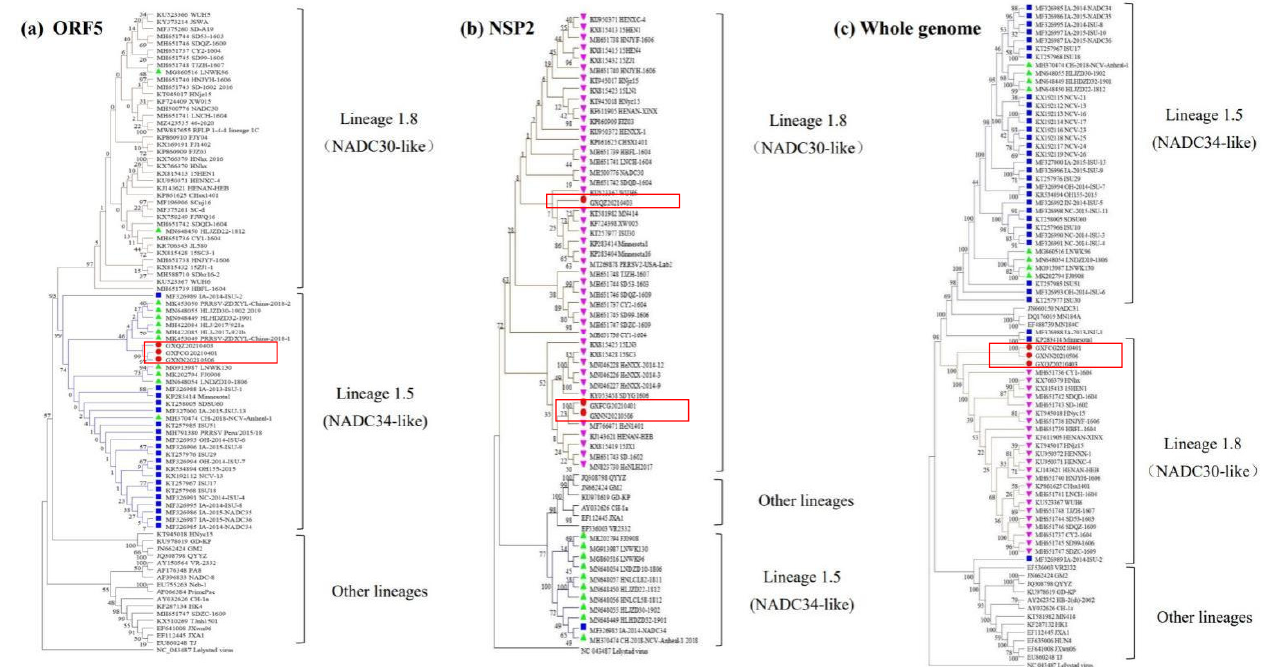
Figure 2. ( a ) Genetic evolutionary tree of the ORF5 gene. ( b ) Genetic evolutionary tree of the nsp2 gene. ( c ) Genetic evolutionary tree of the full-length genome. The categorization of the sub-lineage was based on the description by Shi et al. [10]. The phylogenetic tree was constructed using the Mega 6.0 distance-based neighbor joining method, with a total of 1000 replicates. The virus strains obtained in this study are marked with red circles and red boxes. The Chinese NADC34-like isolates are marked with green triangles. The American and Peruvian 1-7-4 PRRSV strains are labelled with blue squares. The NADC30-like isolates are marked with pink triangles. In the evolutionary tree branches, the NADC30-like strains are indicated by brown lines, the NADC34-like strains are indicated by blue lines and the other lineages and sub-lineages are indicated by black lines.